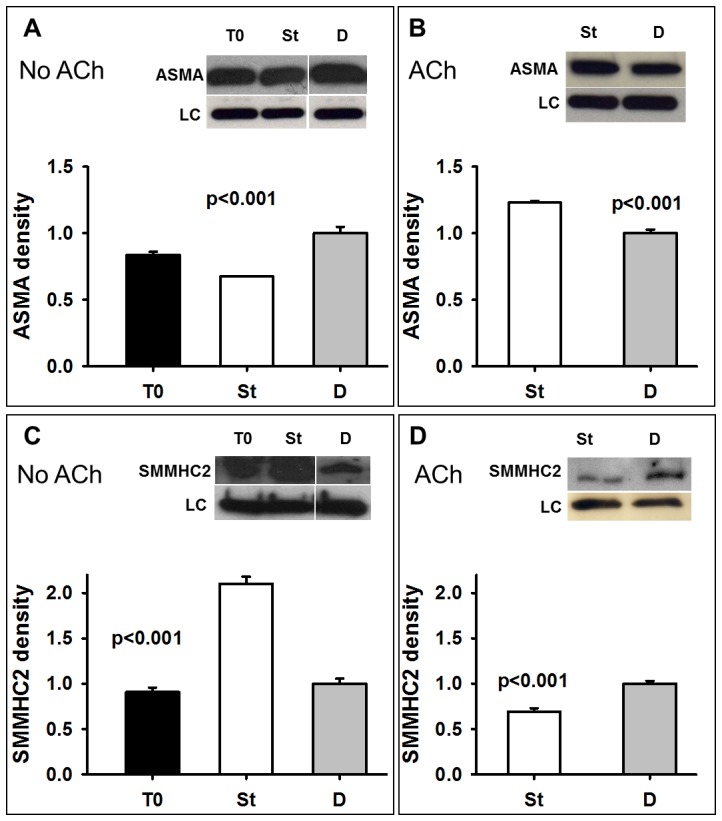
Tidal stretch has opposite effects on ASMA and SMMHC2 levels in constricted airways than in non-constricted airways.Effects of Ptm on the cross-bridge forming contractile proteins α-smooth muscle actin (ASMA, ∼42 KDa) (A and B) and smooth muscle myosin heavy chain 2 (SMMHC2, ∼230 KDa) (C and D) in intact bovine airways after 90 min of mechanical loading with (B and D) or without (A and C) constriction assessed by Western blot. T0: time 0 before stretch, St: static Ptm. D: dynamic Ptm oscillation. GAPDH (∼35 KDa) is loading control. Data are normalized such that the mean of the dynamic group is unity.